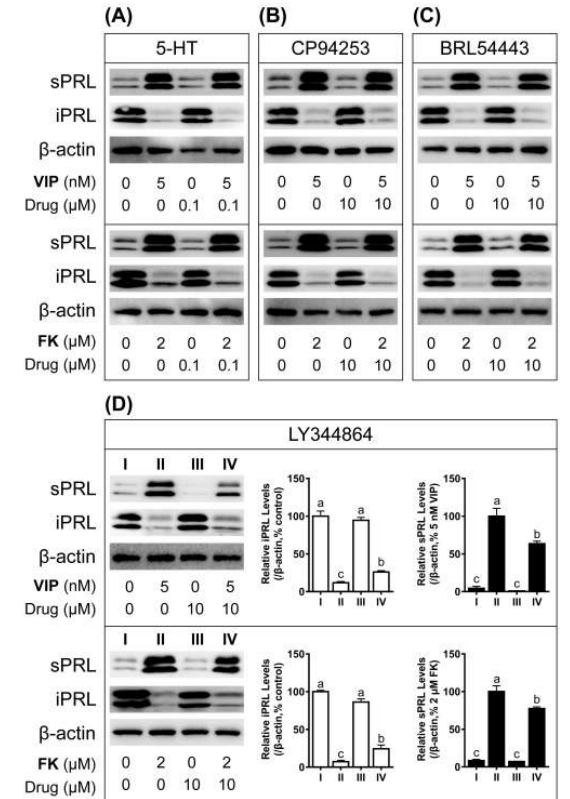
Figure 8. Western blot showing the effects of various selective agonists (( A ): 5-HT; ( B ): CP94253; ( C ): BRL54443; ( D ): LY344864) on VIP (5 nM) or forskolin (FK, 2 µ M)-stimulated cPRL secretion in cultured chicken pituitary cells. sPRL represents secretory PRL, and iPRL represents intracellular PRL. Protein levels were semi-quantified by densitometry, β -actin was used as an internal control. For the sPRL analysis, the 5 nM VIP or 2 µ M FK treated group was regarded as 100%, while for the iPRL analysis, the control group (without any drug treatment) was regarded as 100%. Different letters indicate statistical difference between two groups ( p ≤ 0.01), as determined by one-way ANOVA and a Tukey’s test. Each data point represents the mean ± SEM of three replicates ( n = 3). The cPRL bands were observed at 24 kDa and 27 kDa (glycosylated form), as reported in our previous studies